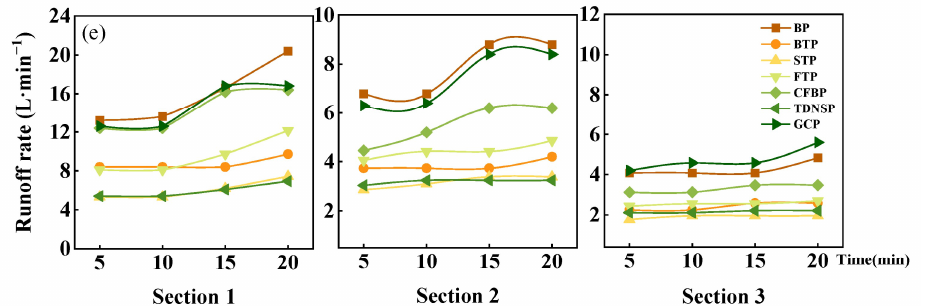
Figure 6. Runoff rates of seven measures under different inflow time. ( a ) Inflow rate = 2.5 L · min − 1 . ( b ) Inflow rate = 5 L · min − 1 . ( c ) Inflow rate = 10 L · min − 1 . ( d ) Inflow rate = 15 L · min − 1 . ( e ) Inflow rate = 20 L · min − 1 . Note: In Sections 1–3, the distance from the observation section to the top of the runoff plot is 1 m, 3 m, and 5 m,